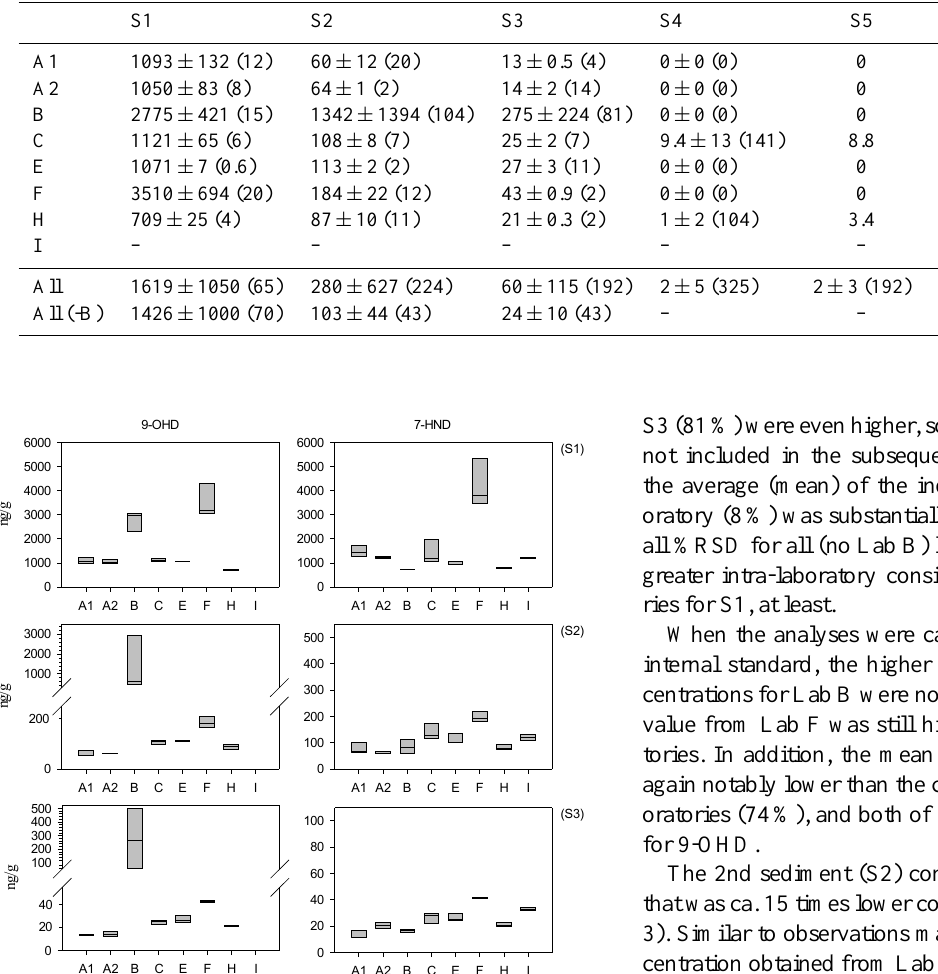
Table 2. Summary of IP 25 concentrations (ngg − 1 ) for all sediments and laboratories. Values correspond to mean ± sd (%RSD) and have been obtained using 9-OHD as an internal standard. Values are either rounded to the nearest integer ( > 1) or shown to 1 significant figure ( < 1). Data for S5, E1 and E2 from individual laboratories are single measurements. * Relative concentrations.